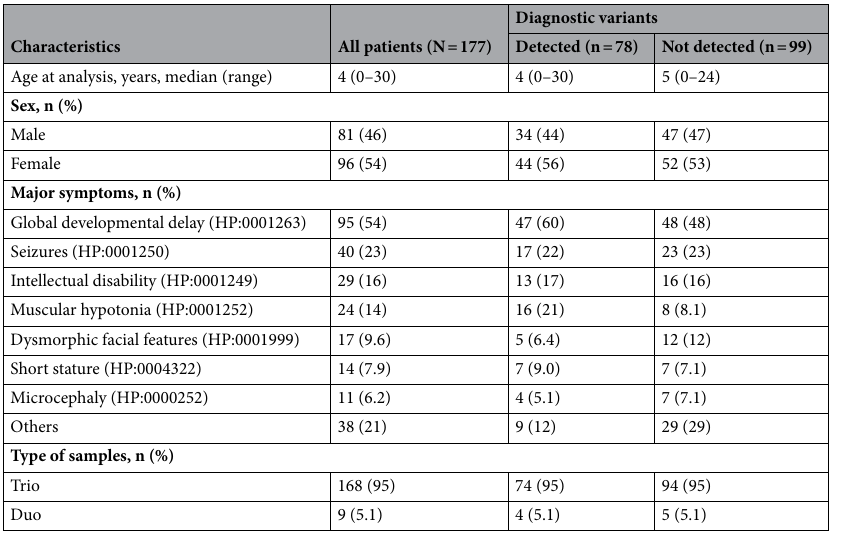
Table 1. Patient